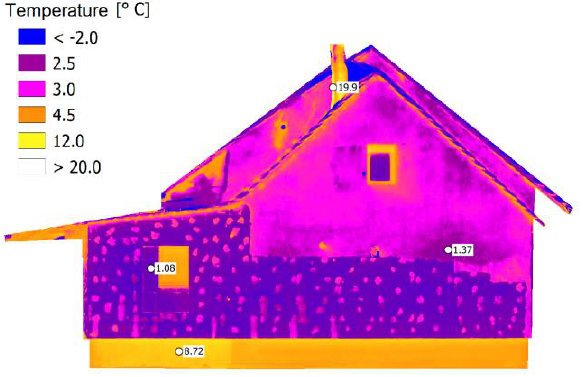
Figure 6. Orthophoto where temperature value is stored in each pixel.